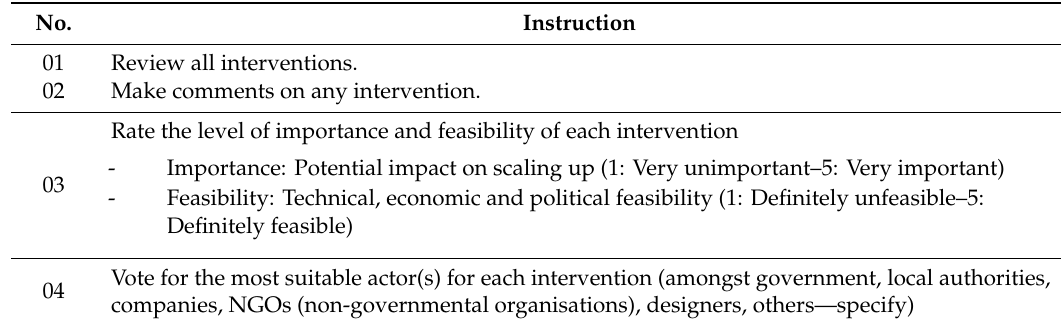
Table 1. Semi-Delphi questionnaire